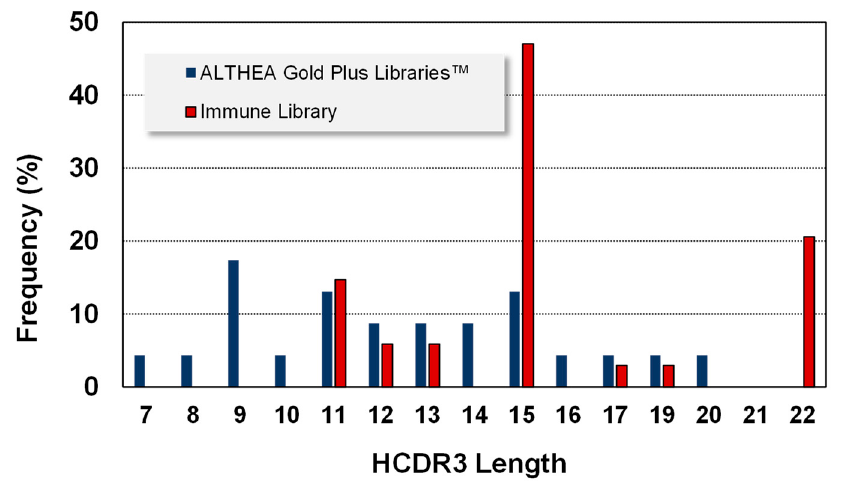
Figure 6. HCDR3 length frequency of the selected clones from ALTHEA Gold Plus libraries™ and the immune library [8].